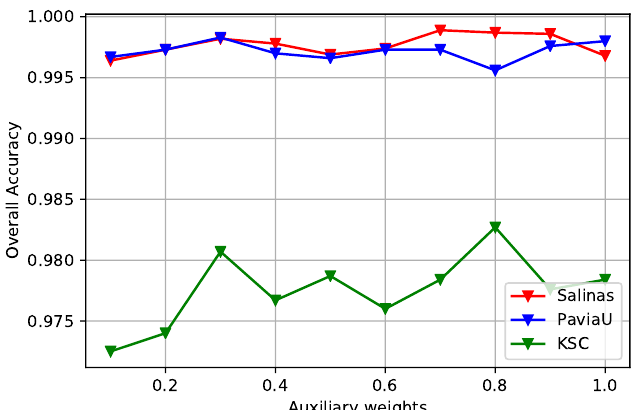
Figure 8. The curves of OA obtained by different multi-scale auxiliary weights for three HSI datasets. The auxiliary weights are set from 0.1 to 1, with an increment of 0.1. The optimal α is determined corresponding to the highest OA value for each